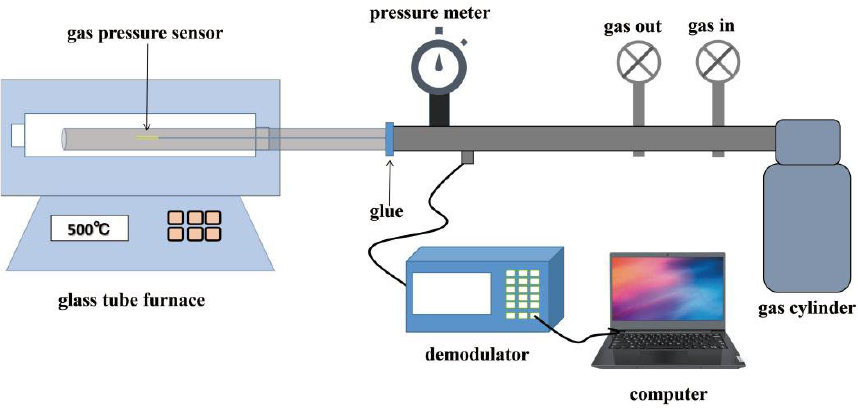
Figure 3. Experimental setup for the characterization of the sensor. Table 1. The comparison between the measured and calculated spatial